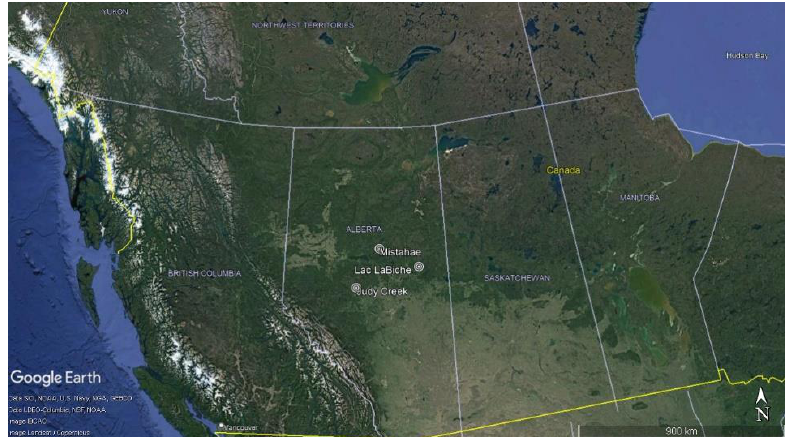
Figure 1. Locations of the three experiments in Alberta in western